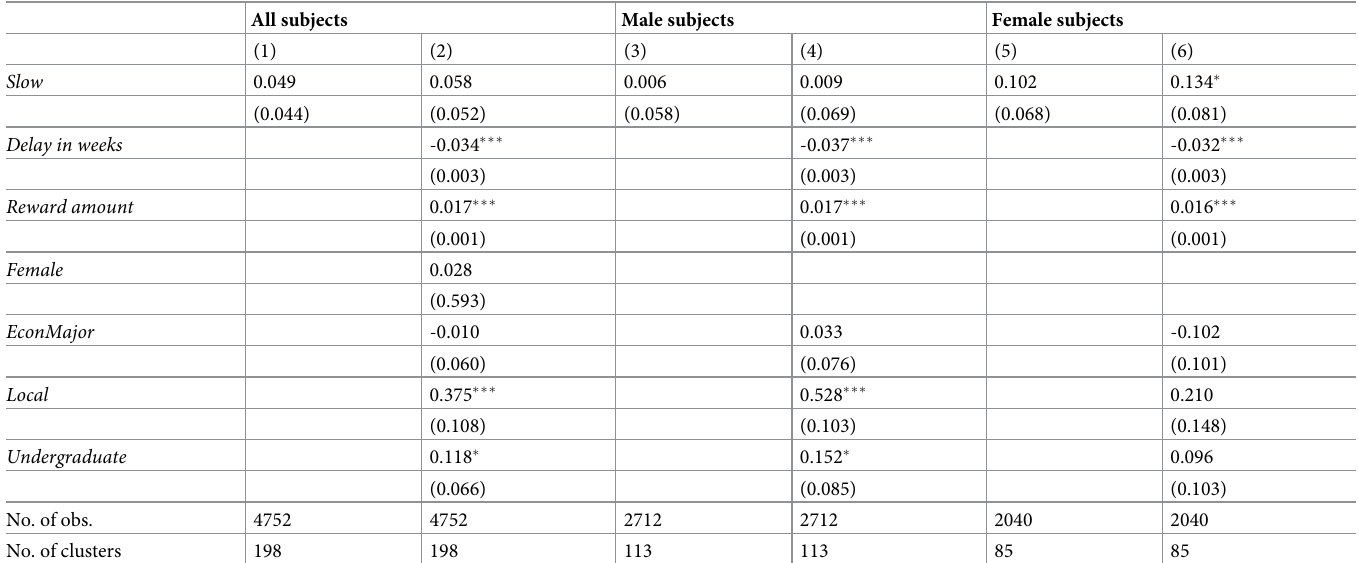
Table 3. Regression